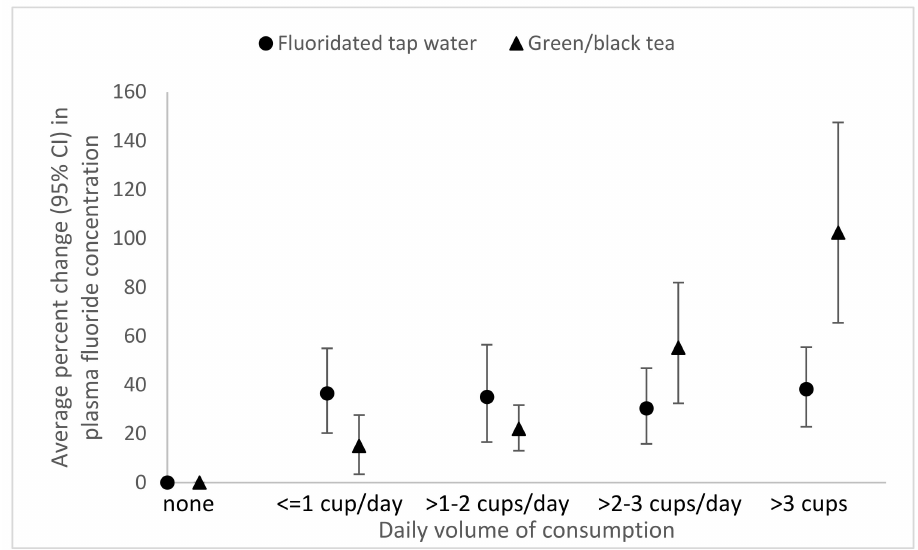
Figure 2. Adjusted percent change (95% confidence interval) in plasma fluoride per number of 8 oz. cups of fluoridated tap water (0 servings / day, n = 3368; > 0–1 servings / day, n = 100; > 1–2 servings / day, n = 152; > 2–3 servings / day, n = 94; > 3 servings / day, n = 214) and green / black tea (0 servings / day, n = 3425; > 0–1 servings / day, n = 135; > 1–2 servings / day, n = 194; > 2–3 or more servings / day, n = 78; ≥ 3 servings / day, n = 96) in 3928 6–19 year old National Health and Nutrition Examination Survey participants from 2013–2016. Adjusted for age, sex, race / ethnicity, fluoridated tap water consumption, and recent green / black tea consumption.